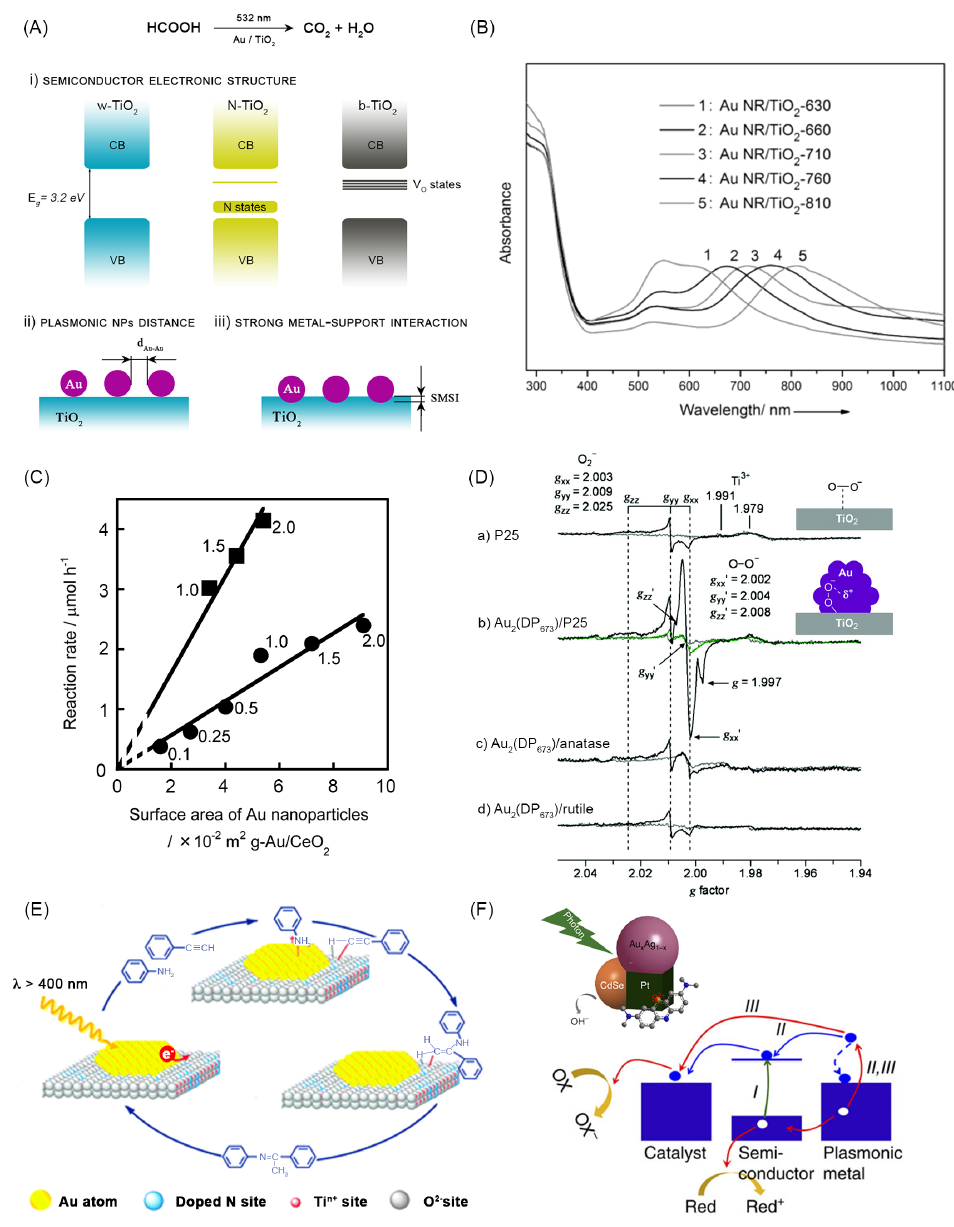
Figure 5: (A) Schematics of plasmonic formic acid photo-oxidation performed on Au/TiO 2 catalysts. In particular, (i) electronic structure of the different investigated semiconductors, (ii) Au NPs inter-distance (d Au − Au ) and (iii) strong metal-support interactions (SMSI). (B) UV/Vis absorption spectra of Au nanorods/TiO 2 photocatalysts exhibiting two distinct absorption features: the oscillation of free electrons along the transversal axis of the NR, peaking at λ ~ 520 nm, and that along the longitudinal direction at λ > 650 nm and strongly affected by the NR aspect ratio. (C) Effect of the external surface area of Au NPs on the rate of benzaldehyde formation, under green LED irradiation and in the presence of O 2 . The plot compares single-step photodeposited Au/CeO 2 (•) and multi-step photodeposited Au/CeO 2 ( (cid:4) ). Values in the figure indicate the nominal amount of Au NPs. (D) EPR spectra of Au/TiO 2 (mixed anatase and rutile phase) treated with 20 Torr O 2 in the dark (grey lines), under visible-light irradiation at 298 K (black lines) or in the dark at 363 K (green line). After evacuation, all the spectra were acquired at 77 K. (E) Proposed mechanism for the photocatalytic hydroamination of alkynes on Au NPs supported on N-doped TiO 2 . (F) Schematics of Pt-Au x Ag 1− x -CdSe non-centrosymmetric hybrid nanostructures (top left) and the different possible reaction pathways for photocatalytic oxidation of methylene blue (in the present study, OX = methylene blue; Red = ethanol). Figures (B-F) adapted with permis- sion from references [106, 107, 109, 111], and [113], respectively. (B): Copyright (2013), Wiley. (C,D): Copyright (2012) American Chemical Society. (E): Copyright (2013) Royal Society of Chemistry. (F) Copyright (2014) Nature Publishing